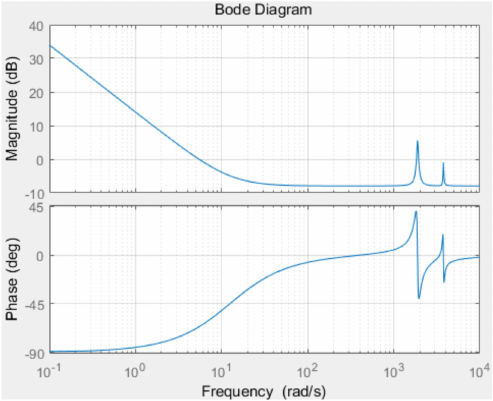
Figure 16. Bode plot of the PI + MR